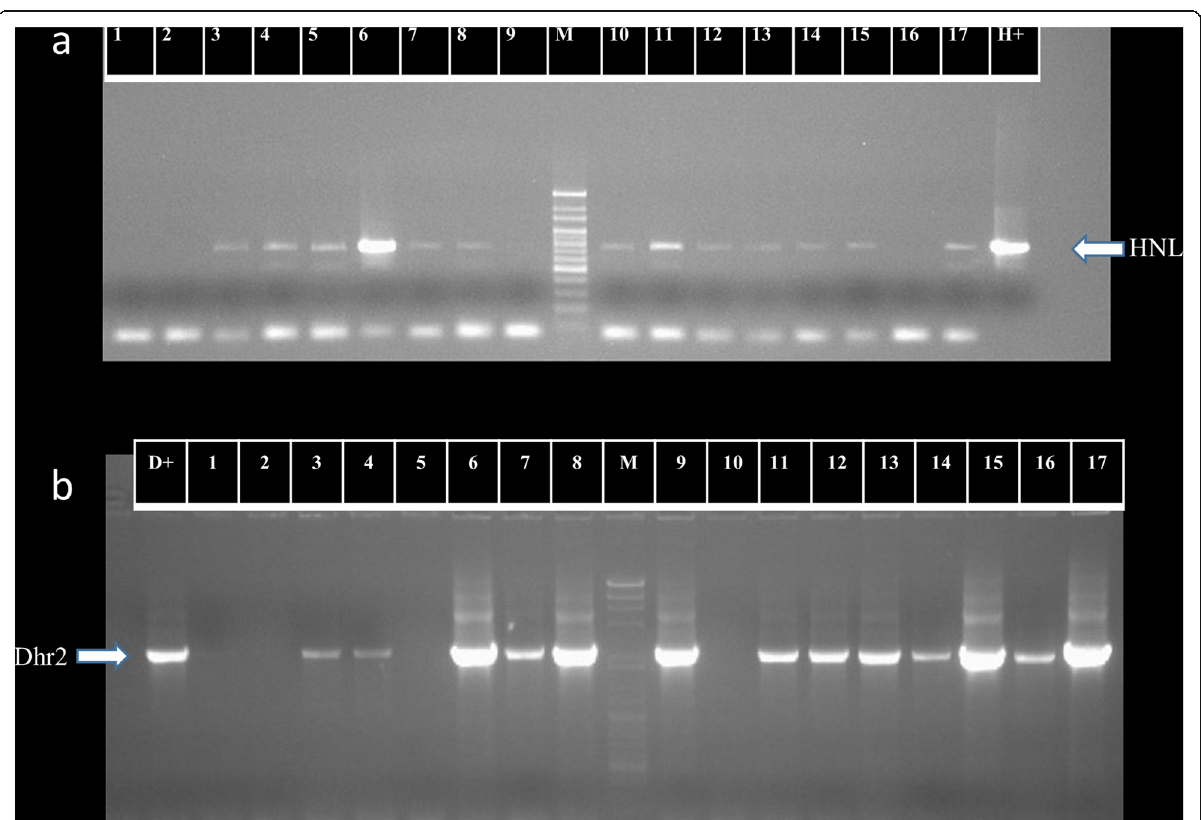
Fig. 6 PCR analysis of transgene in non-agroinfiltrated leaf samples, DNA isolated from non-infiltrated true leaves. a Lane 1: cotton plant as negative control, lane 2: negative control (TRV1: TRV2 infiltrated), lanes 3 ~ 9: plants infiltrated only with pTH2, lanes 10 ~ 17: plants infiltrated with both pTH2 + pTD2 binary vector, M: 2000 bp marker, H+: positive control for MeHNL gene. b Lane 1: cotton plant as negative control, lane 2: negative control (TRV1: TRV2 infiltrated), lanes 3 ~ 9: plants infiltrated only with pTD2, lanes 10 ~ 17: plants infiltrated with both pTH2 + pTD2 binary vector, D+: positive control for SbDhr 2, M: marker ( Hin d III λ -DNA marker mixed with 2000 bp marker)